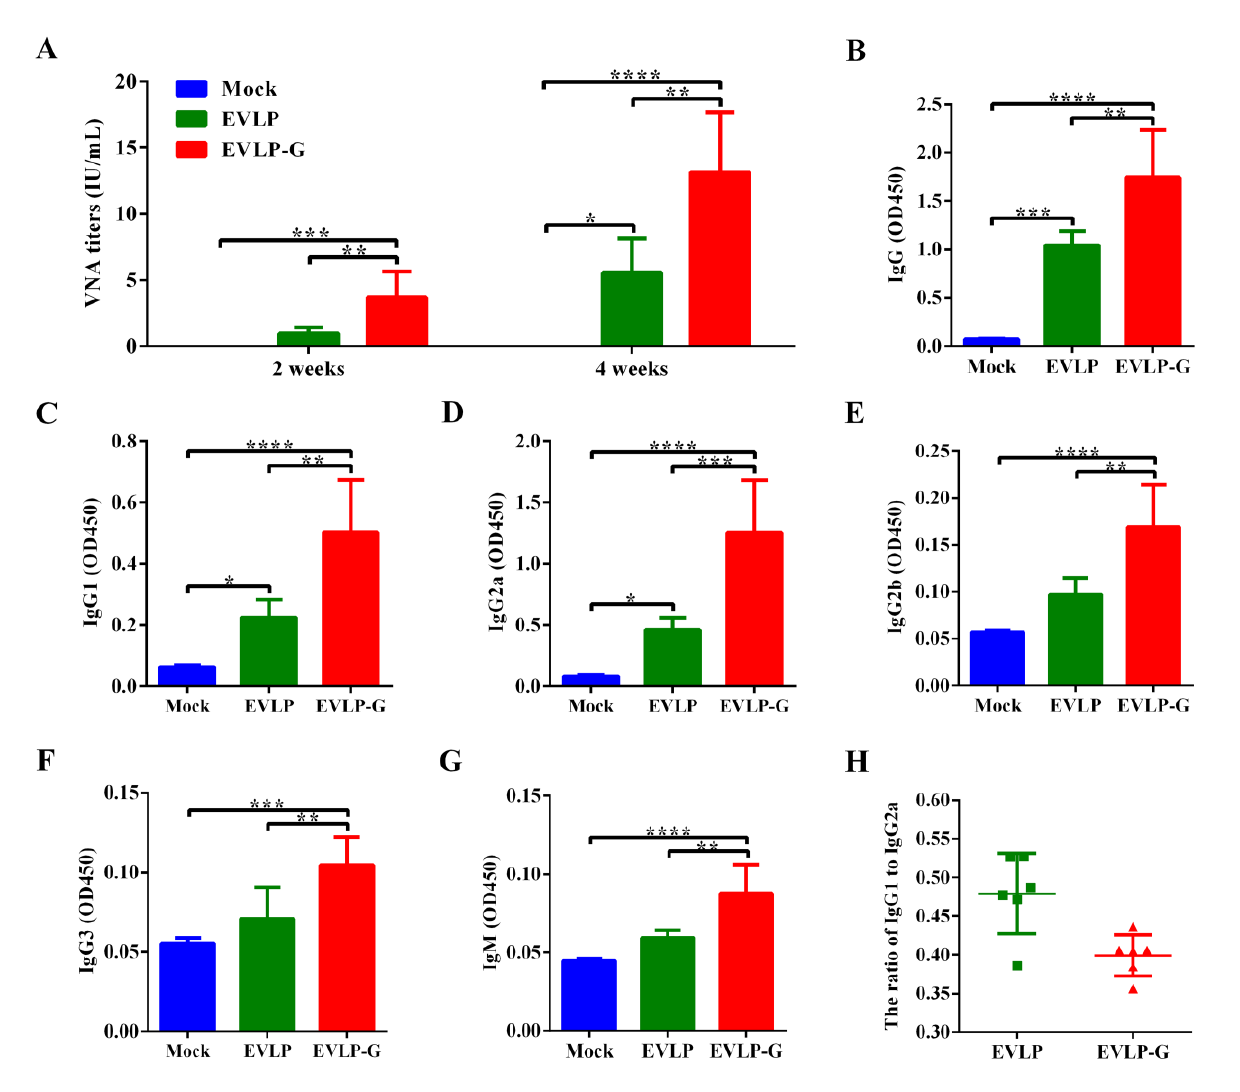
Figure 2. Specific anti-RABV antibody response induced by EVLP-G. Mice were immunizated twice with EVLP-G via i.m. route at 2-week intervals. ( A ) The production of specific anti-RABV VNA. Serum were collected at 2 and 4 weeks after vaccination, and the VNA titers were measured by FAVN; ( B – H ) The serum specific anti-RABV antibody subclass responses were detected as described in Material and Methods; The IgG ( B ), IgG1 ( C ), IgG2a ( D ), IgG2b ( E ), IgG3 ( F ) were determined at 2 weeks after the second immunization, while IgM ( G ) were evaluated at 7 days after the first immunization; And the ratio of IgG1/IgG2a ( H ) were measured. Representative data are the mean ± standard deviation (SD) of 8 mice from each group and were analyzed by one-way ANOVA (* p < 0.05, ** p < 0.01, *** p < 0.001, **** p <